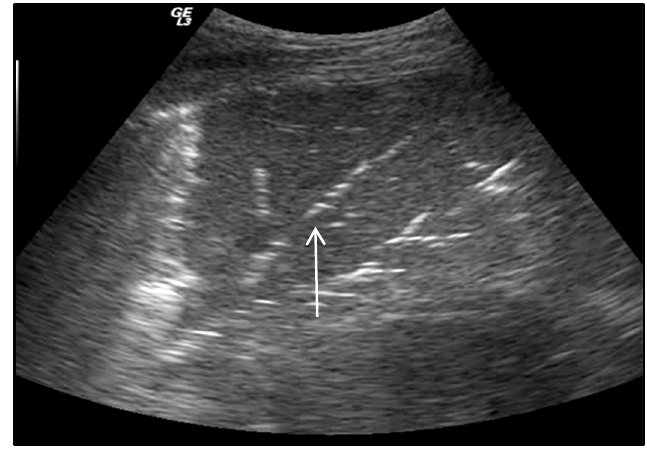
Figure 5. “Tissue-like pattern” with air bronchogram inside (arrow).